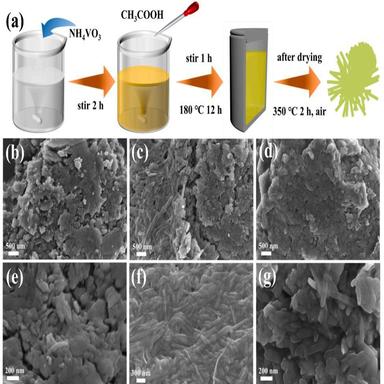
(a) Schematic representation of chemically controlled synthesis of V2O5/VO2 with heterojunctions. SEM images of VO-2 (b, e), VO-5 (c, f) and VO-8 (d, g).